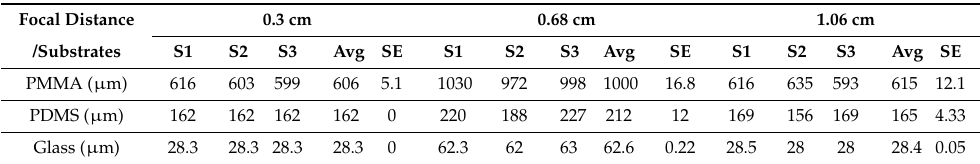
Table 1. Channel depth of laser machined microchannel for various distances between the substrate and focusing lens.